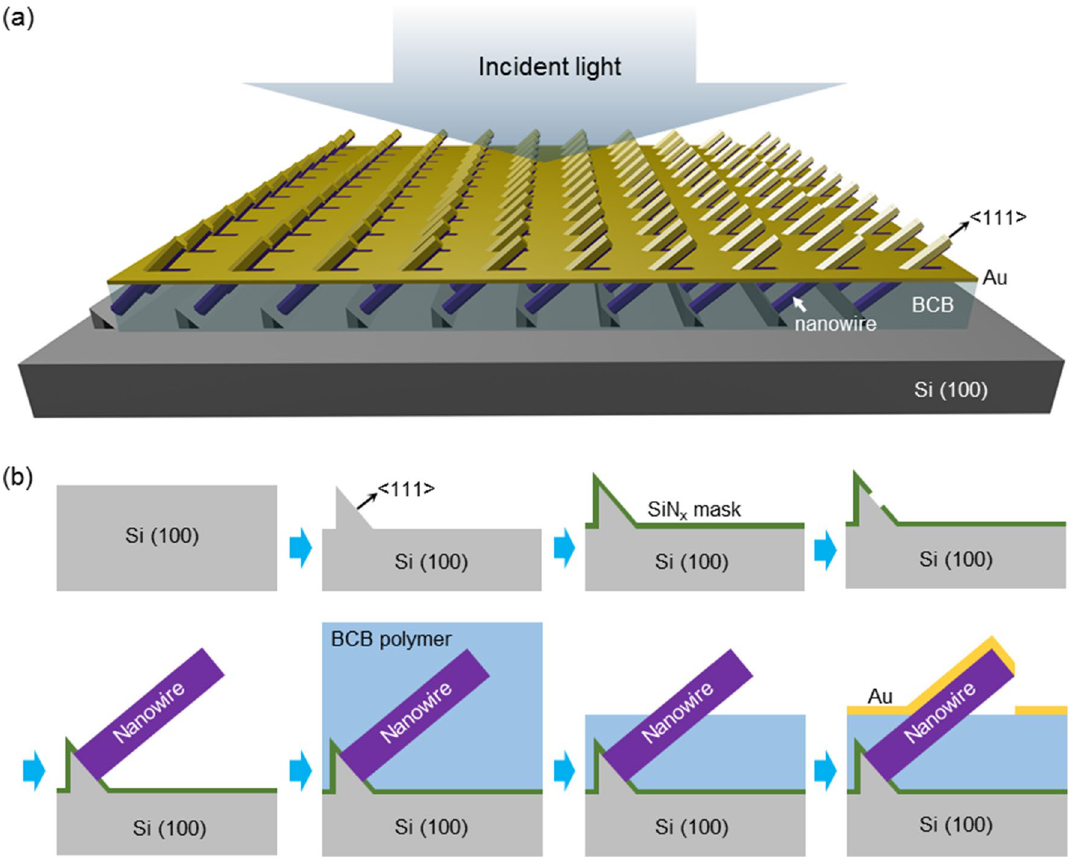
Figure 1. Proposed design. ( a ) Schematic of proposed nanowire-gold hybrid meta-absorber. ( b ) Fabrication processes of the meta-absorber, employing silicon etching, SiN x dielectric masking, III–V nanowire epitaxy, BCB polymer spacer formation, and self-assembly of gold nanostructures by